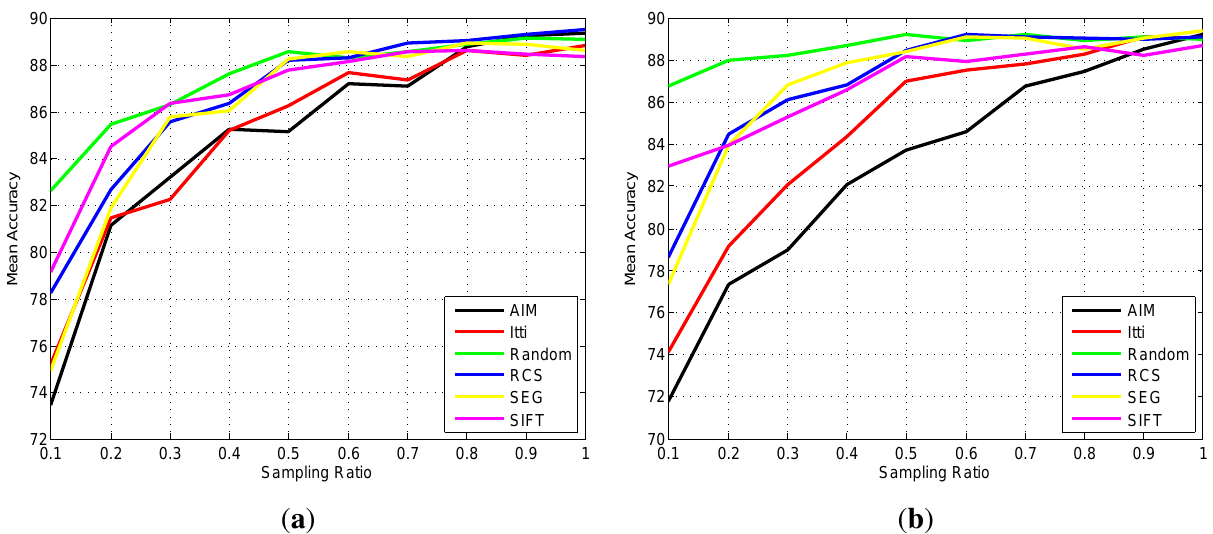
Figure 17. The classification accuracy using different sampling methods on the UC-Merced dataset ( a ) and the RS19 dataset ( b ) using the Fisher kernel framework.